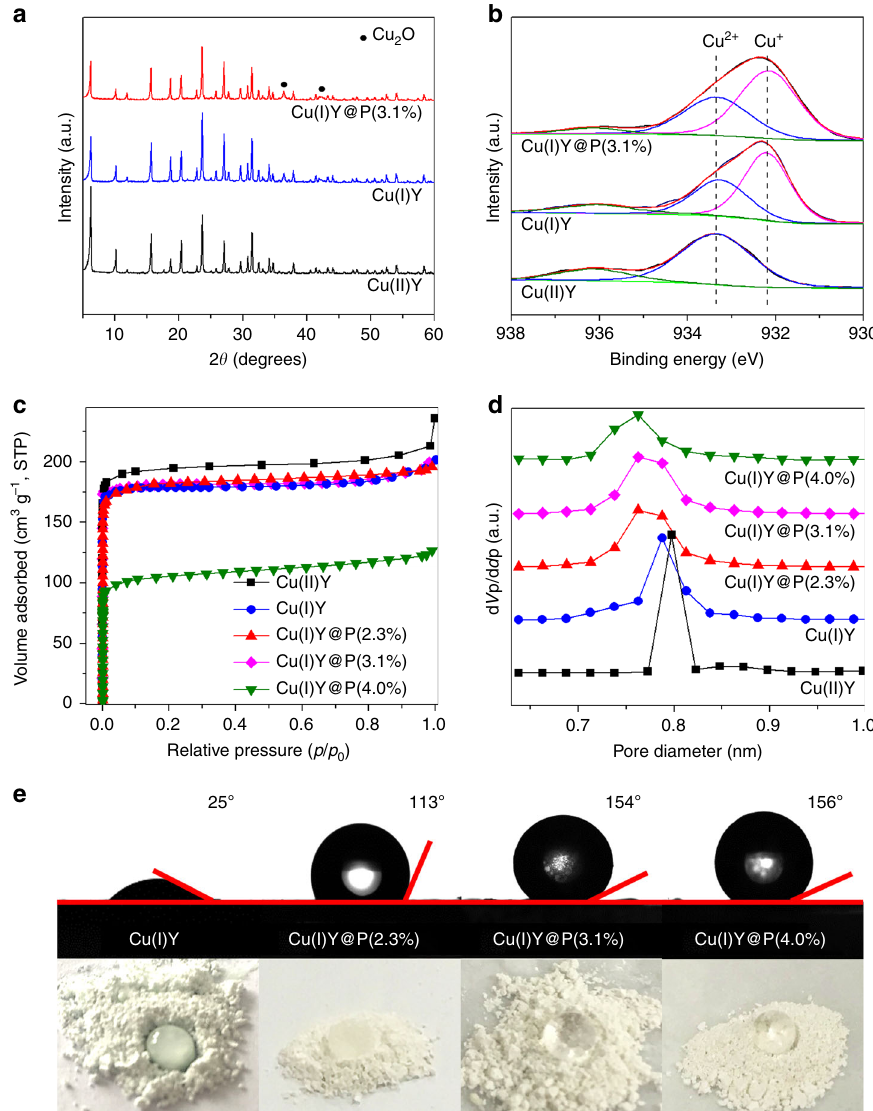
Fig. 2 Characterization of zeolites before and after coating PDS. a XRD patterns and b XPS spectra of Cu(II)Y, Cu(I)Y, and Cu(I)Y@P(3.1%); c N 2 adsorption isotherms and d pore size distributions of Cu(II)Y, Cu(I)Y, and Cu(I)Y@PDS; e Static water contact angles and pictures of different samples with a drop of